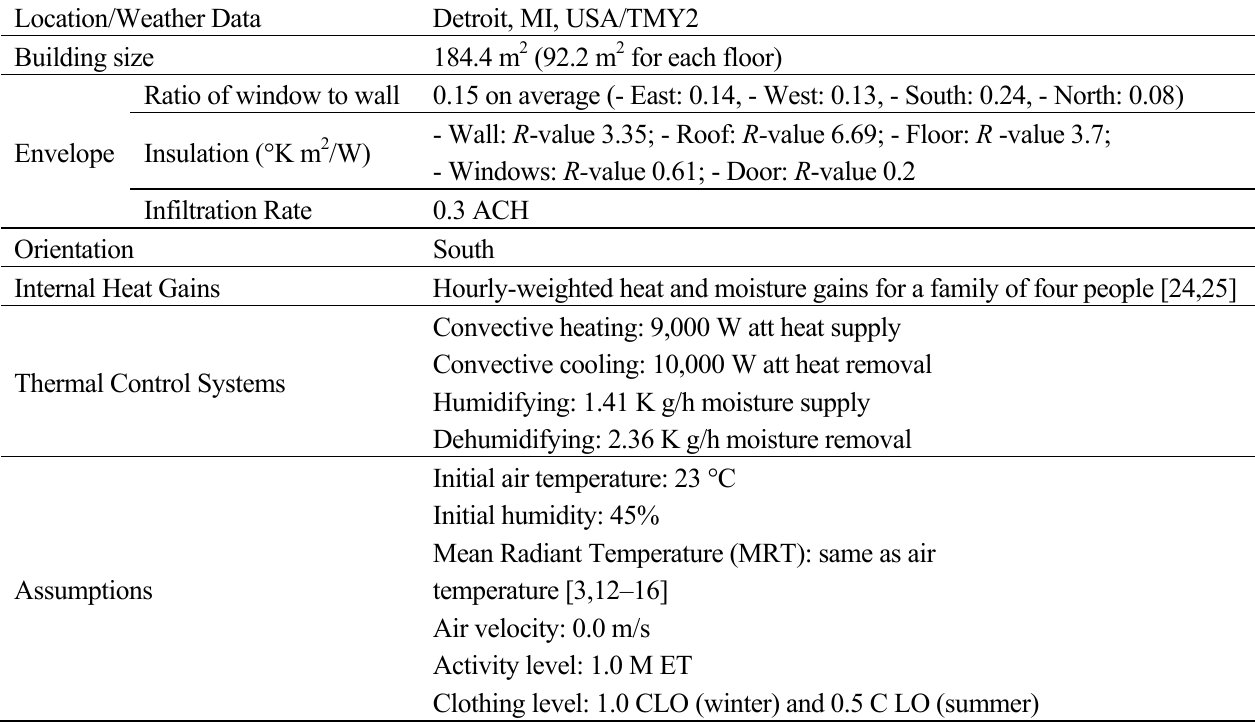
Table 2. Thermal properties for tested